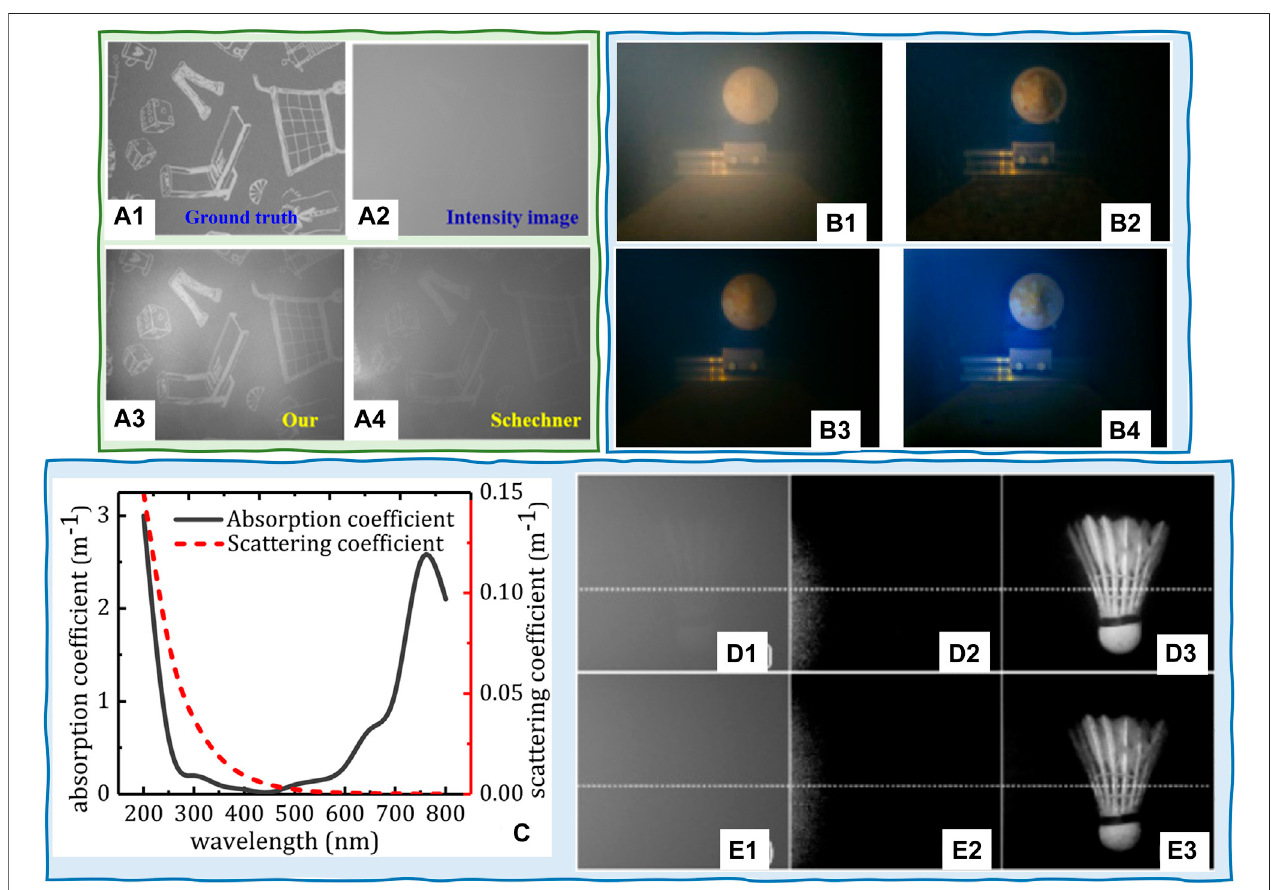
FIGURE 6| (A) (A1) Ground truth and (A2) the raw intensity imageunder water. Comparison of recovered scenes by using (A3) Li ’ s[2] (labeled as “ Our ” ) and (A4) Schechner ’ s [32] methods (reprinted from Springer Nature: Scienti fi c Reports [2], copyright 2018). Comparison of the recovered images when the raw image is (B1) : using (B2) DCP, (B3) DCP with transmission map by soft matting, and (B4) Brosseau ’ s method (reprint from OSA: Optics Express [80], copyright 2019). (C) Measured absorption and scattering coef fi cients of pure seawater (reprint from OSA: Optics Letters [82], copyright 2018). (D1) and (E1) Directly captured images in 41 NTU and70NTUturbidwater; (D2) and (E2) resultsfromtraditionalpolarizationimagingmethod; (D3) and (E3) fi nallydetectedimagesbytheLiu ’ smethod(reprintfromOSA: Optics Letters [82], copyright 2018).